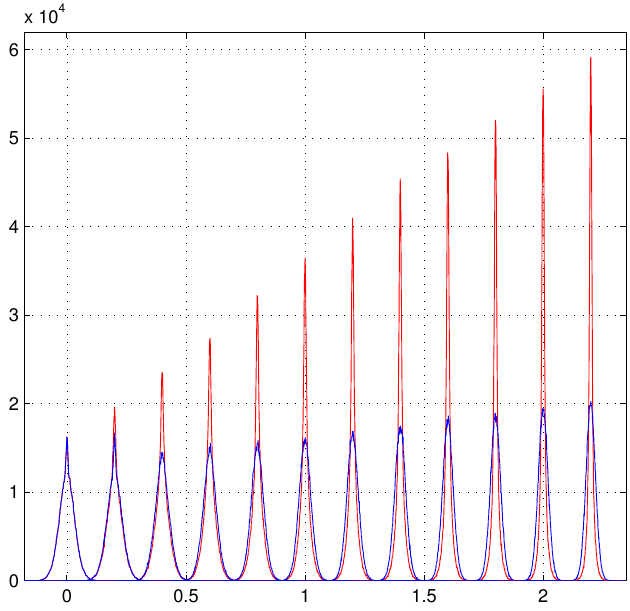
Figure 1. Empirical PDFs of the fitted (straight) track direction for tracker models with N = 2 to N = 13 detecting layers. The PDFs for N = 2 are centered on zero, the others are shifted by N-2 steps of fixed amplitude. The blue PDFs are the results of the standard least-squares. The red PDFs are obtained with the weighted least-squares. (The reported dimensions are pure